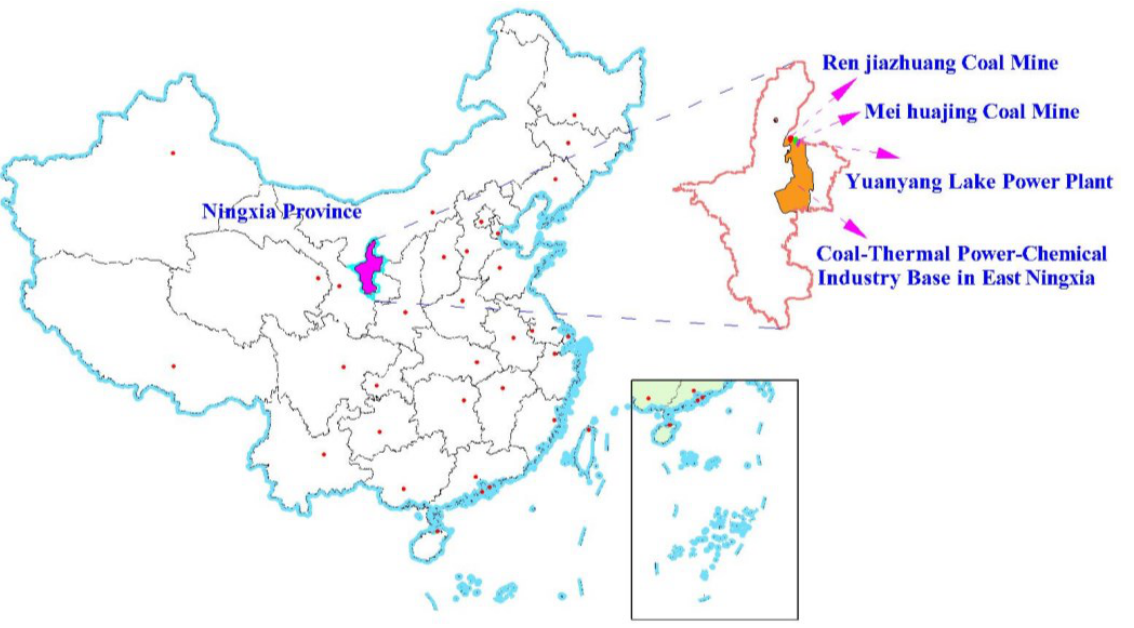
Figure 6. The geographical location of the mining area and sources of coal-based solid waste materials. Table 2. Particle size composition of gangue.